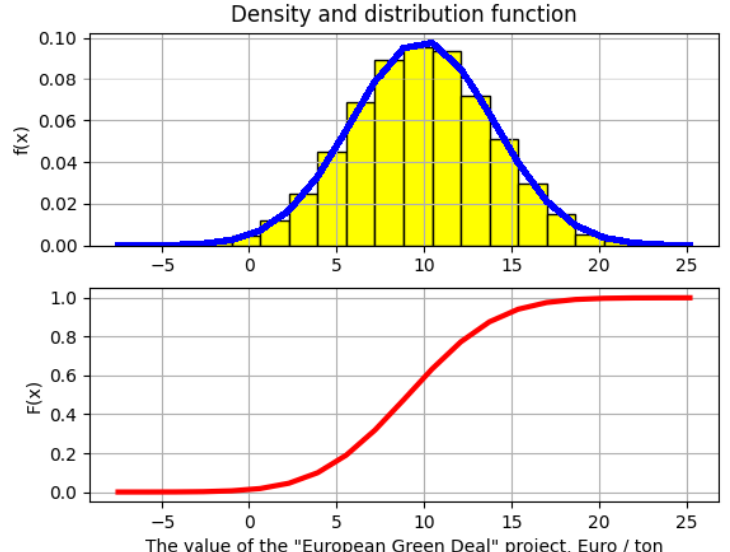
) for project V ) for pro- ij нij R